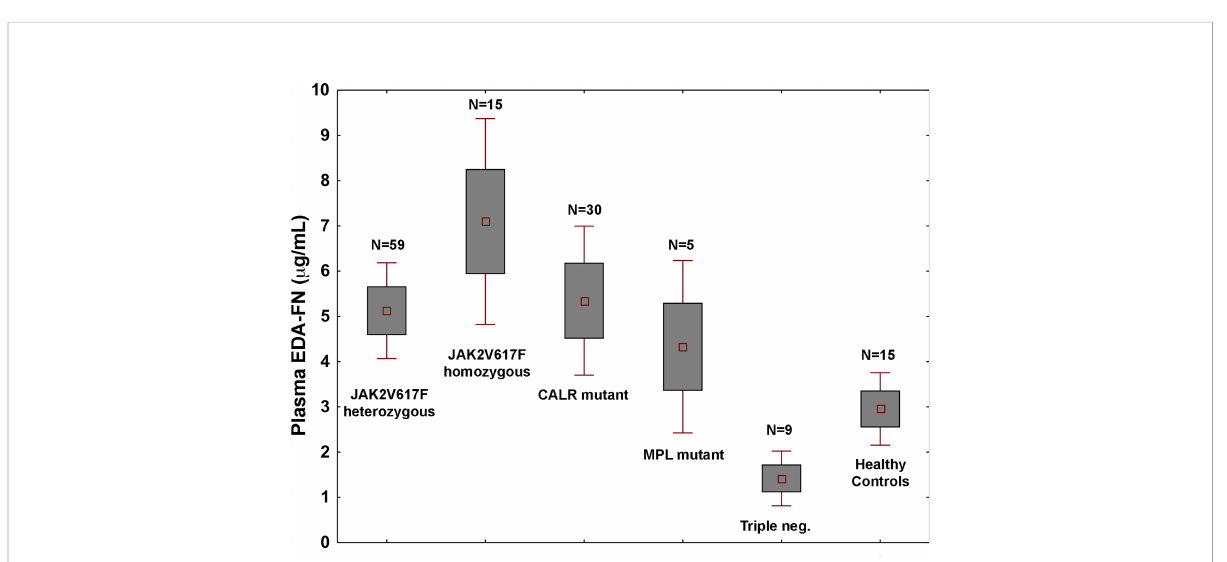
Plasma EDA-FN in m g/mL ± SD , mean, median (range) *Spleen index is the product of the longitudinal by the transversal spleen axis, the latter de fi ned as the maximal width of the organ. Splenectomized patients were excluded from the study. Non-palpable spleens were set at 90 cm 2